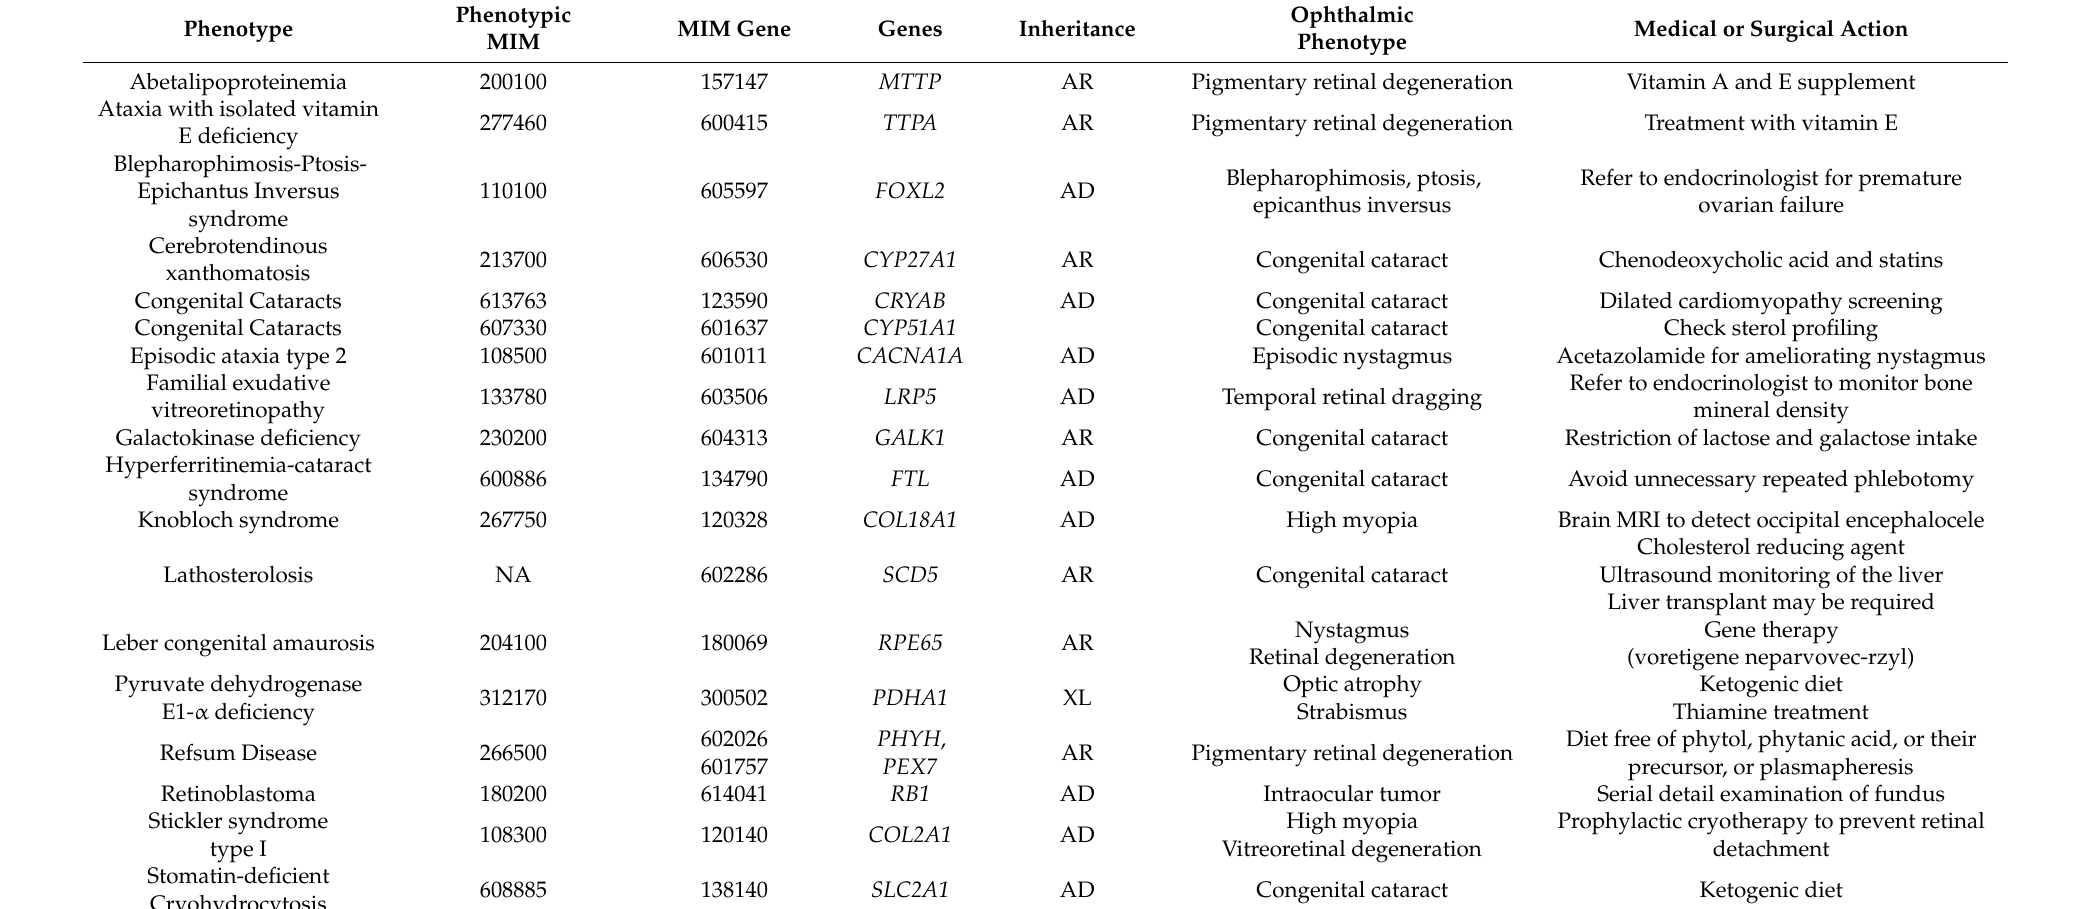
Table 3. Medically or surgically actionable genes in inherited eye